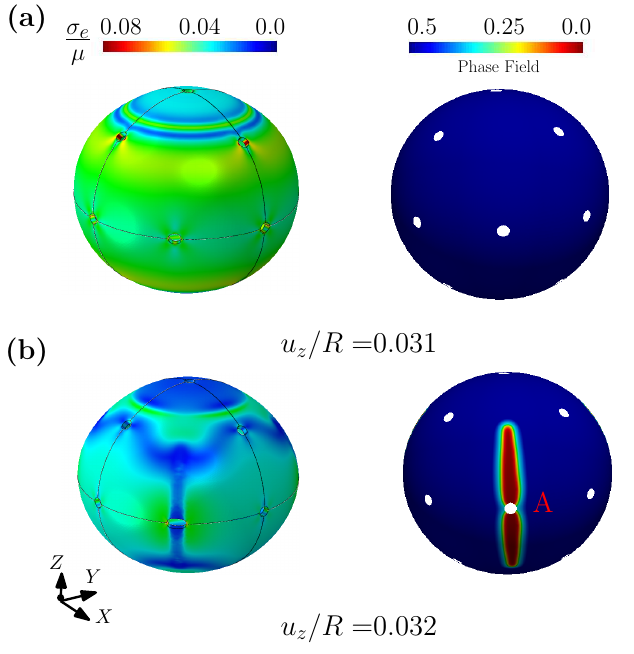
Figure 9. The contour plots of normalized effective Cauchy stress and phase field for spherical shell considering compression, under different displacement u z / R =: ( a ) 0.031; ( b ) 0.032.